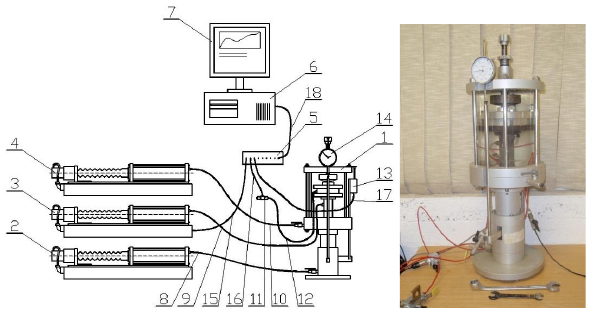
Figure 4. Components of the measuring station and connection of devices (description in text). 12.5, 25, 50 and 100 kPa. Initial sample height =20 mm and diameter =75 mm was used. The results of the experiment are presented in Figure 5.